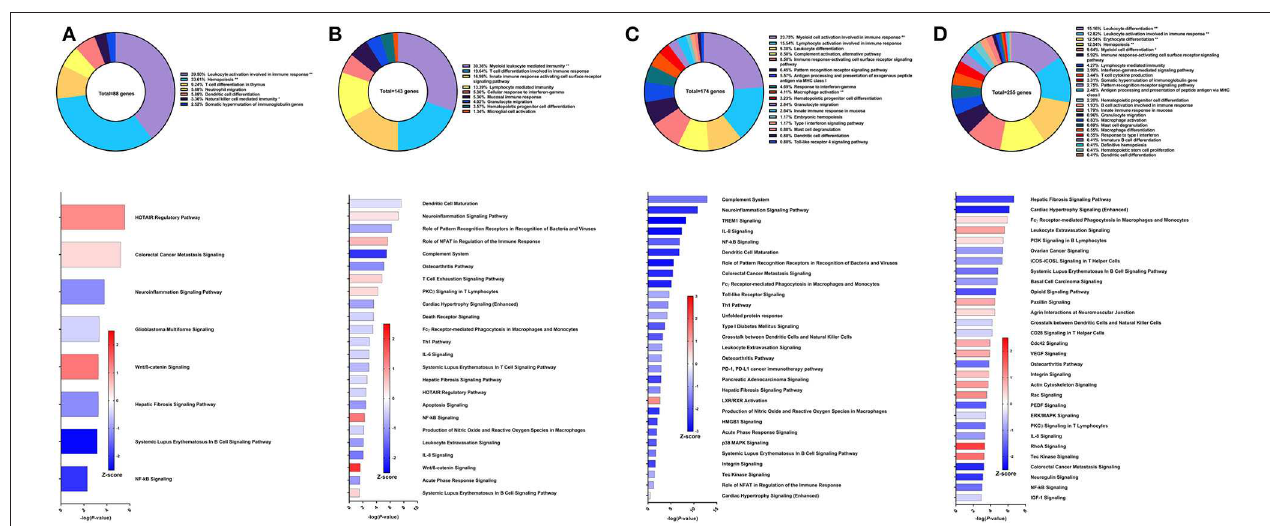
FIGURE 4 | RNA-Seq analysis of Sm-p80-VR1020 + rSm-p80 + Resiquimod, a prime/boost vaccine strategy. (A) PBMCs after vaccination (Top) Gene ontology enrichment analysis represented as a pie graph of percentages of genes per group out of a total number of differentially expressed genes. “**” and “*” indicates P < 0.05 and P < 0.01, respectively. (Bottom) Canonical pathway analysis generated using IPA. Bars are plotted based on the – log10( P -value) and colored based on predicted activation (red) and deactivation/inhibition (blue) according to the Z-score, a composite assessment based on the degree of overlap between directional expression of genes from the observed data and the Qiagen-curated public database. The top 30 pathways are shown based on the lowest P -values. (B) PBMCs after challenge (Top) Gene ontology enrichment analysis. (Bottom) Canonical pathway analysis generated using IPA. (C) Spleen cells (Top) Gene ontology enrichment analysis. (Bottom) Canonical pathway analysis generated using IPA. (D) Mesenteric lymph node cells (Top) Gene ontology enrichment analysis. (Bottom) Canonical pathway analysis generated using